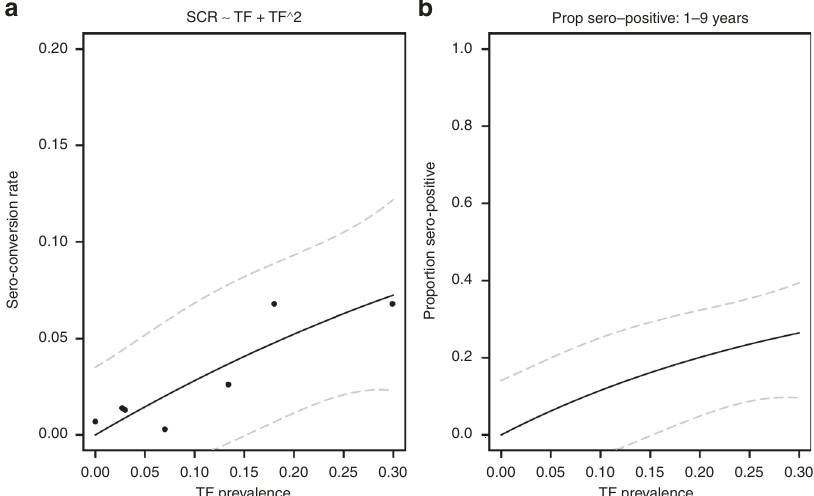
Fig. 3 The estimated relationship between the sero-conversion rate (SCR) and TF prevalence and the predicted proportion of people sero-positive. a Black dots indicate the median estimated SCR for each dataset and the TF prevalence from each of the 9 study sites. The solid black line is the mean predicted relationship between the SCR and TF prevalence, obtained by fi tting a linear model to the data. The 95% con fi dence intervals about the mean relationship are indicated as grey dashed lines. b The predicted mean proportion of people sero-positive for a given level of TF prevalence is shown with a solid black line, the 95% con fi dence intervals about this mean are indicated with dashed grey lines. For the elimination as a public health problem threshold of TF <5%, we would expect 6.2% (95% CI: 0.0 – 19.9%) to test